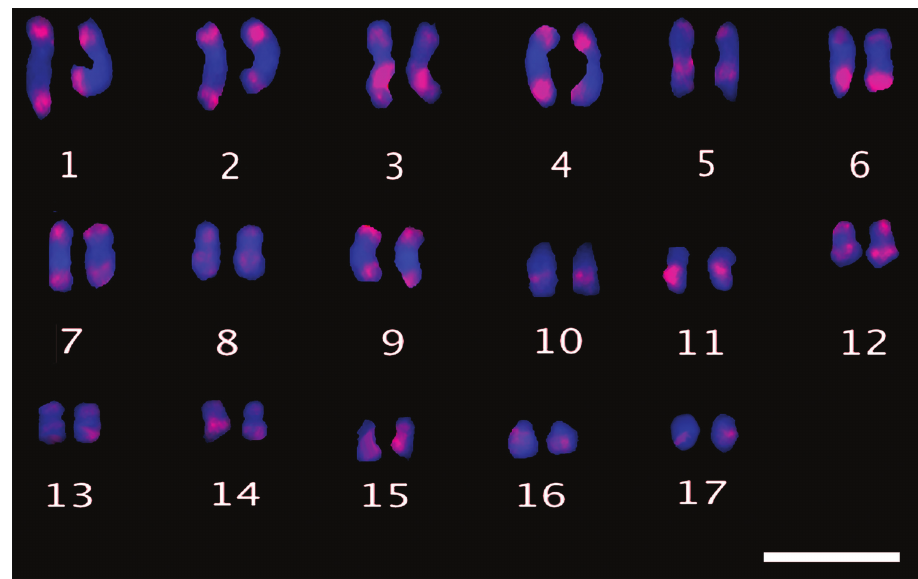
Figure 7. An example of globe artichoke pairing of homologous chromosomes based on (GA) pattern. Scale bar: 5 µm.